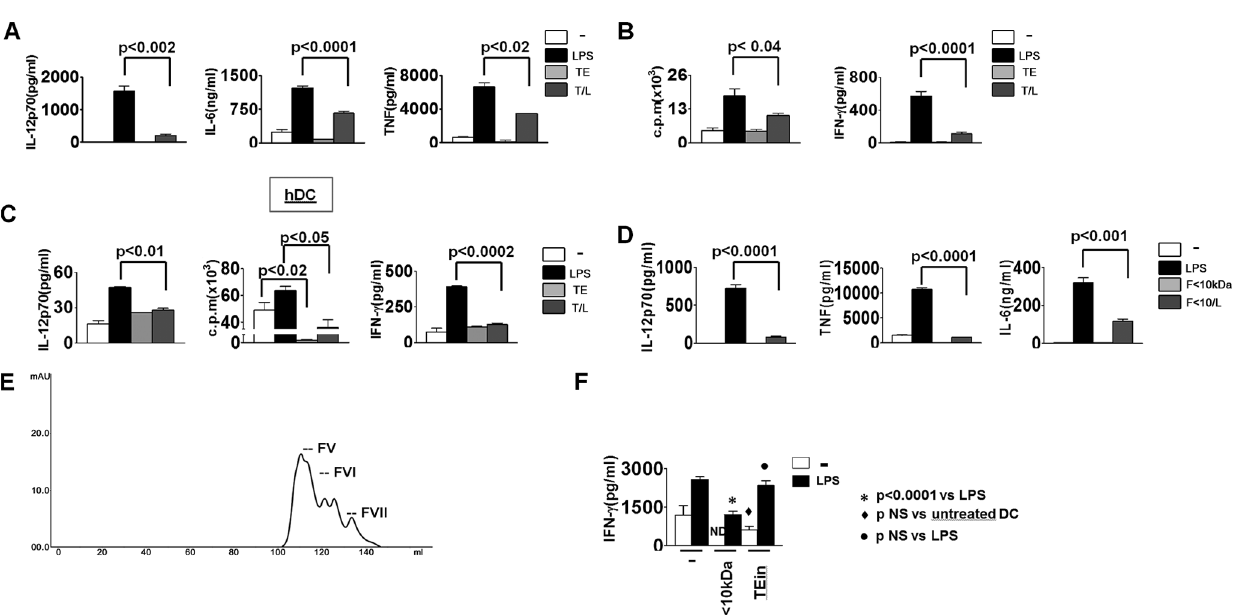
Fig. 1. Proteins lower than 10 kDa from TE modulate mouse and human DC maturation and their allostimulatory capacity. (A) DC from BALB/c mice were incubated with medium, LPS (1 m g/ml), TE (80 m g/ml) or TE plus LPS (T/L) for 18 h and cytokine concentration was evaluated in the supernatants by ELISA. (B) DC from BALB/c mice treated as described in A, were co-cultured for 5 days with C57BL/6 splenocytes at a 1:10 ratio. Allogeneic responses were determined by the proliferative 3[H]-thymidine incorporation assay and IFN- c production by ELISA. (C) hDC from healthy donors treated with medium, LPS (100 ng/ml), TE (80 m g/ml) or T/L for 24 h were cultured with allogeneic PBMC at 1:10 DC:PBMC cell ratio and the proliferative and IFN- c response were tested. (D) IL-12p70, TNF and IL-6 were detected by ELISA in the supernatant of DC treated with medium or F , 10 kDa (20 m g/ml) in the presence or absence of LPS for 18 h. (E) Elution profile of proteins lower than 10 kDa from TE, obtained by the ultrafiltration membrane with a cutoff lower than 10 kDa (F , 10 kDa). (F) DC from BALB/c mice were treated with medium, F , 10 kDa (20 m g/ml) or TE incomplete, without F , 10 kDa (TEin, 80 m g/ml), and OVA peptide (0.5 m g/ml) in the presence or absence of LPS (1 m g/ml), before being cultured with splenocytes from DO11.10 TCR-transgenic mice, and IFN- c production was evaluated after 5 days. Data show the mean of at least four wells ¡ SD, and are representative at least of two experiments with similar results, with p representing a significant difference in the Student’s t-test.